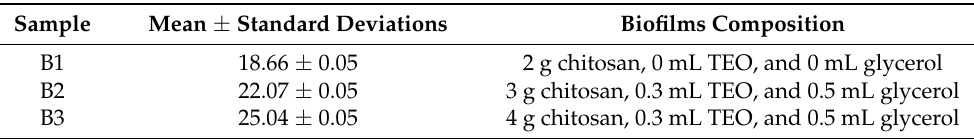
Table 8. Mean values ( ± standard deviation) of elongation (%) obtained from biofilm formations of: